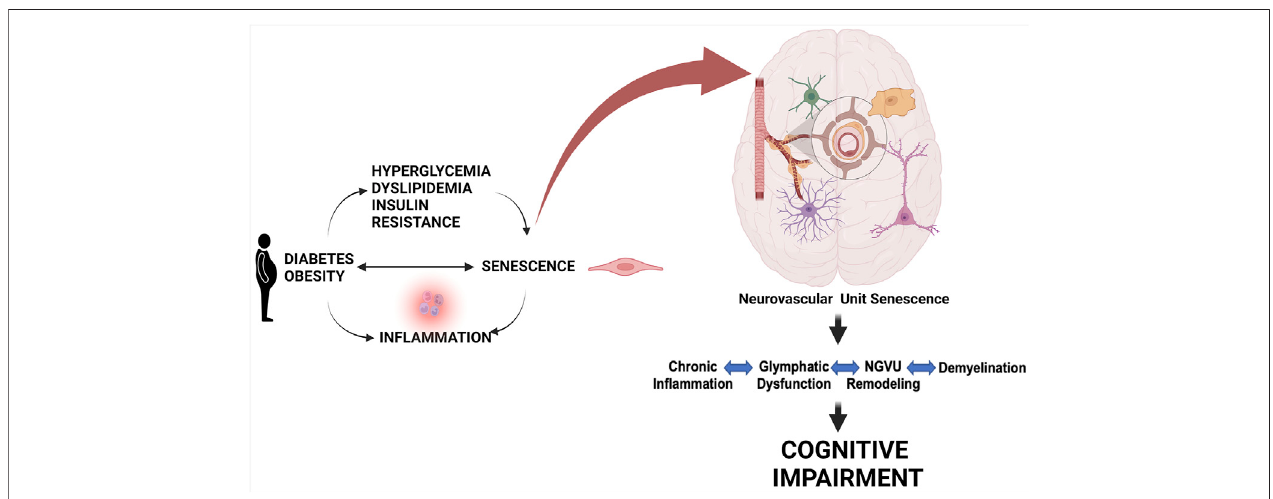
FIGURE 3 | Role of cell senescence in metabolic disease-associated cognitive impairment. Metabolic diseases including obesity and diabetes and conditions linked to them like hyperglycemia, dyslipidemia, and insulin resistance can lead to a senoin fl ammatory loop. Senescence of pancreatic cells can also lead to diabetes. This persisting senescence at the cellular level targeting the components of the NGVU gradually leads to chronic in fl ammation, glymphatic dysfunction, NGVU remodeling, and demyelination resulting in progressive cognitive impairment. Created with